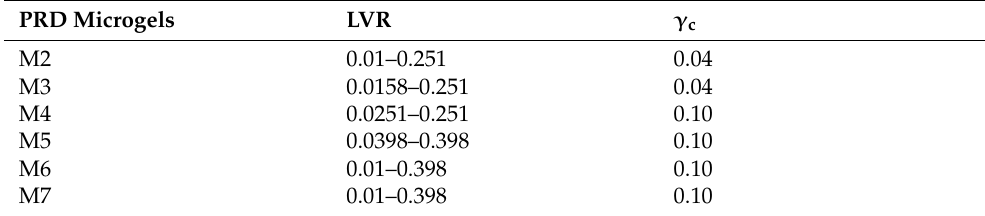
Table 8. Linear viscoelastic region (LVR) and critical strain ( γ c ) of PRD microgels at 35 ◦ C. PRD Microgels